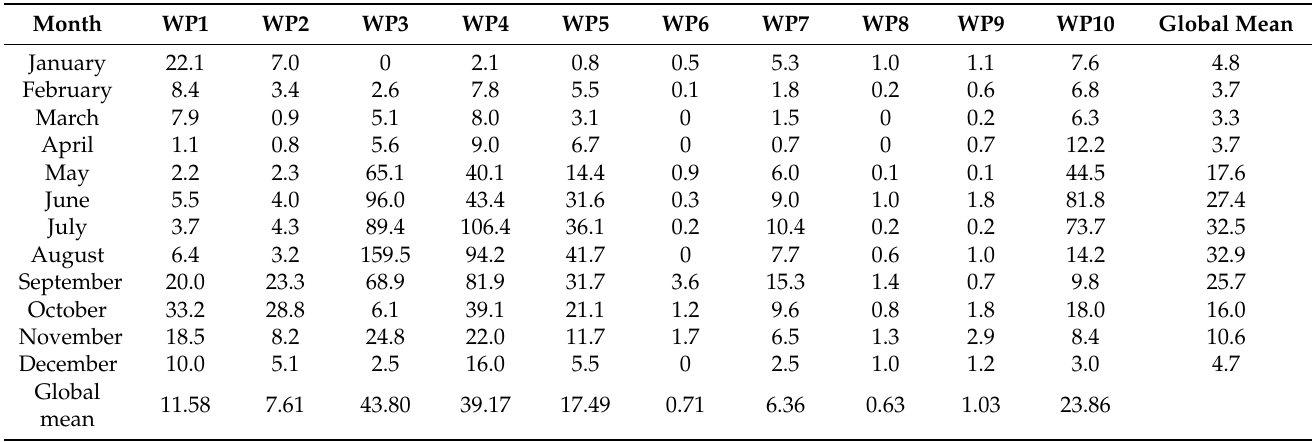
Table 5. Mean monthly number (observation period 2011–2020) of recorded negative lightning strikes per wind park and global mean per wind park and